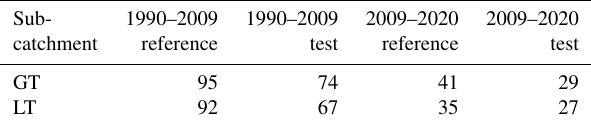
Table 4. Comparison of the number of detected slope-type debris flows of the test mapping with a reduced number of orthophotos and the original mapping (reference). This mapping was conducted in GT and LT and for the time steps 1990–2009 and